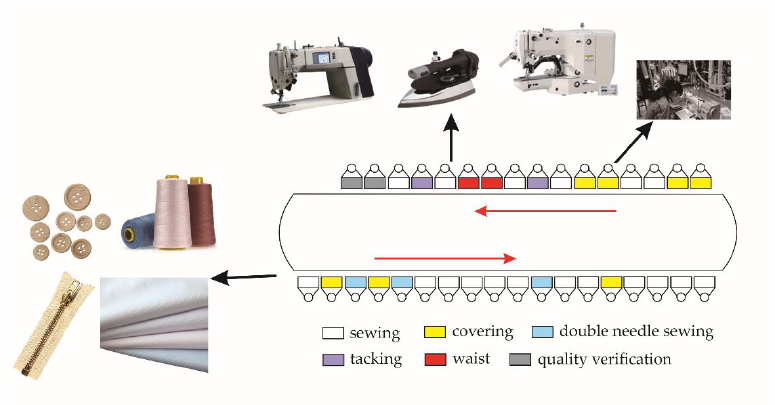
Figure 1. The Process of Garment Sewing.